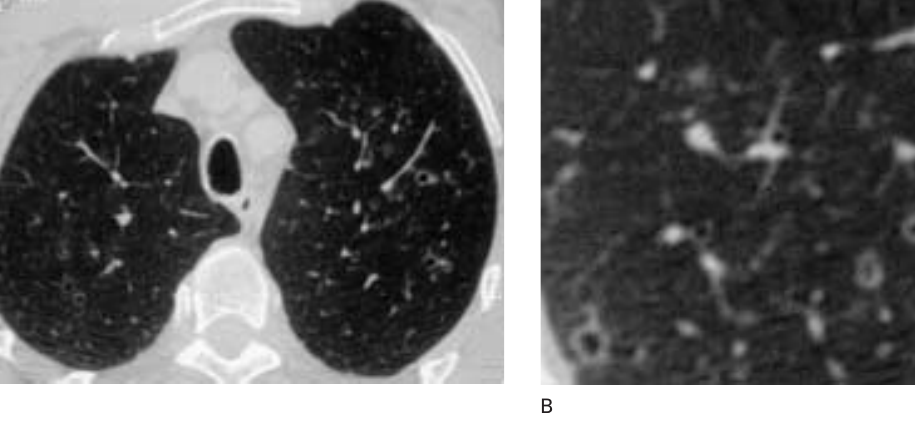
A, B: Computed to- mography scans of the lungs showing bilateral intrapul- monary ”ring-shaped